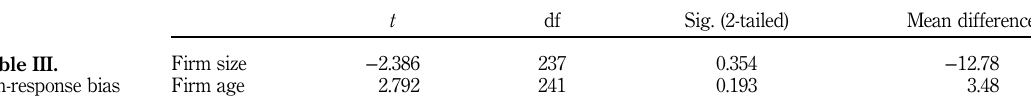
Table II. Business activities of the